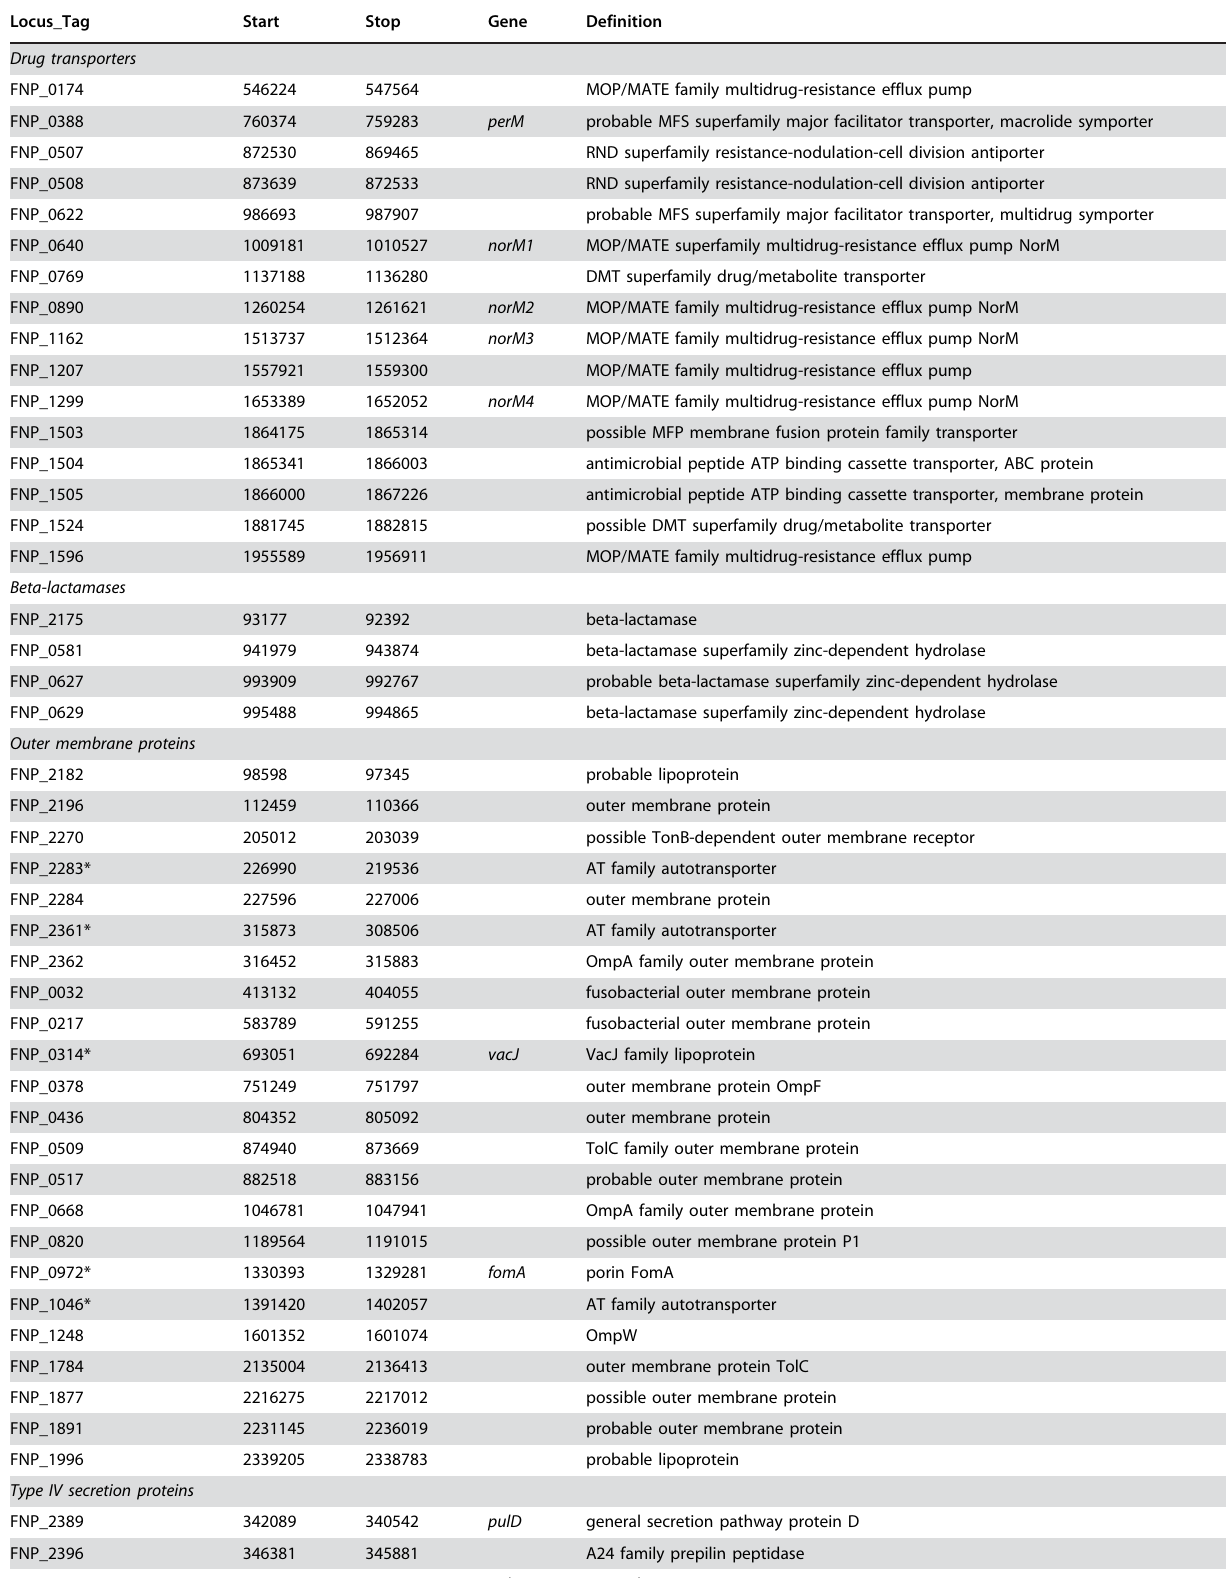
pulG general secretion protein